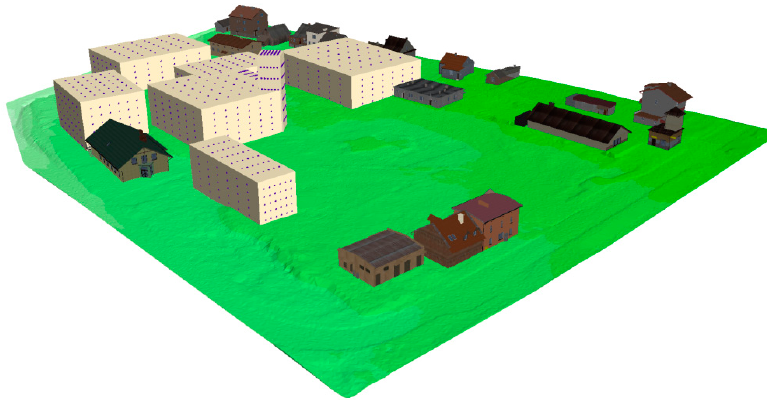
Figure 6. Placement of viewpoints on walls of zones. Source: own work.